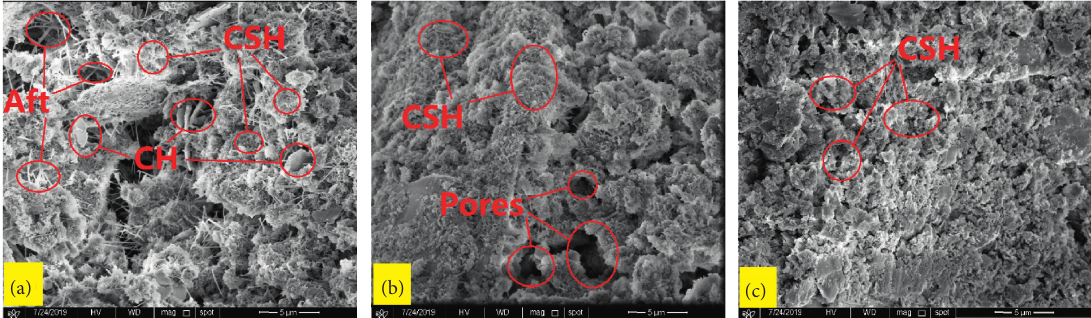
Figure 5: SEM results of CTB samples with slag of different grinding times and curing for 150 days: (a) CTB; (b) CTB-30; (c) CTB-50.